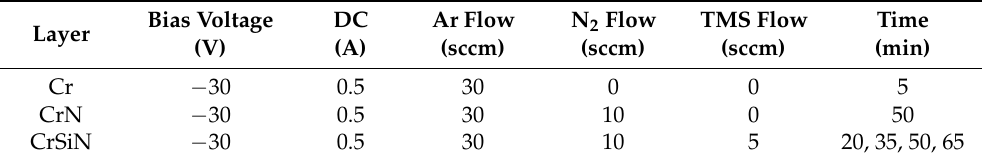
Table 1. The specific deposition parameters of the